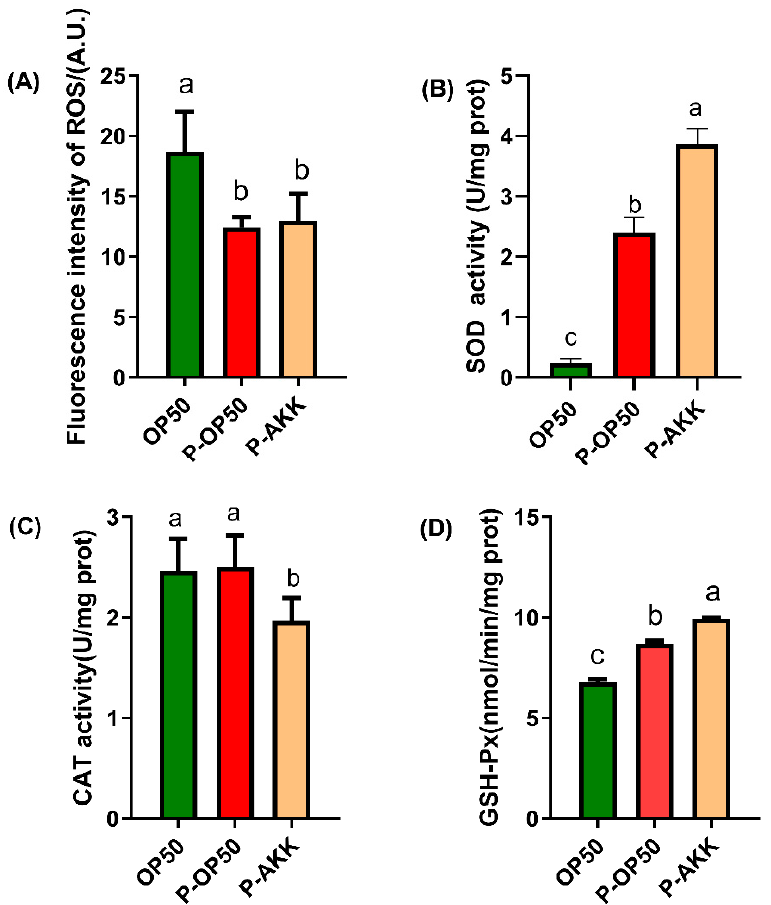
Figure 3. Increase in antioxidant capacity and decrease in accumulation of ROS in C. elegans after p- AKK treatment. ( A ) Results of ROS labeling and detection after treating L4 nematodes with different bacteria for 24 h. N = 3. ( B – D ) SOD, CAT and GSH-PX content in L4 nematodes after feeding with different bacteria for 24 h. N = 3. The results are expressed as the mean ± SD and p -values were calculated by Duncan’s tests. Significant differences between groups are expressed by different letters (a–c) ( p <